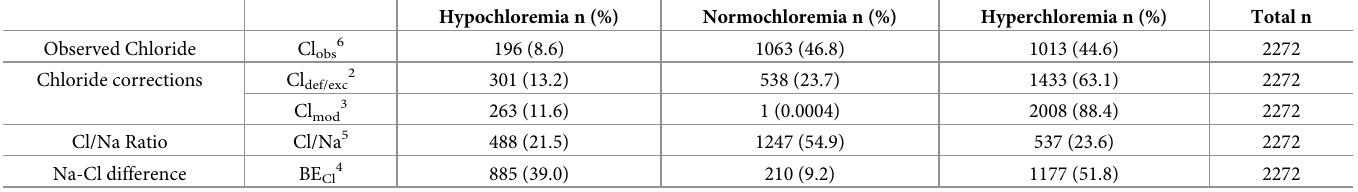
Table 1. Distribution of hypo, hyper and normo-chloremic patients in accordance with different chloride